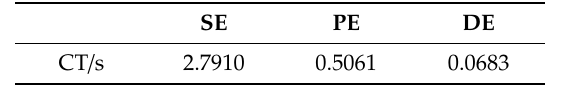
Figure 5. Entropy values of noisy simulated signals. ( a ) sample entropy (SE); ( b ) permutation entropy (PE); and ( c ) dispersion entropy (DE). Table 2. Consuming time of different entropy algorithms.